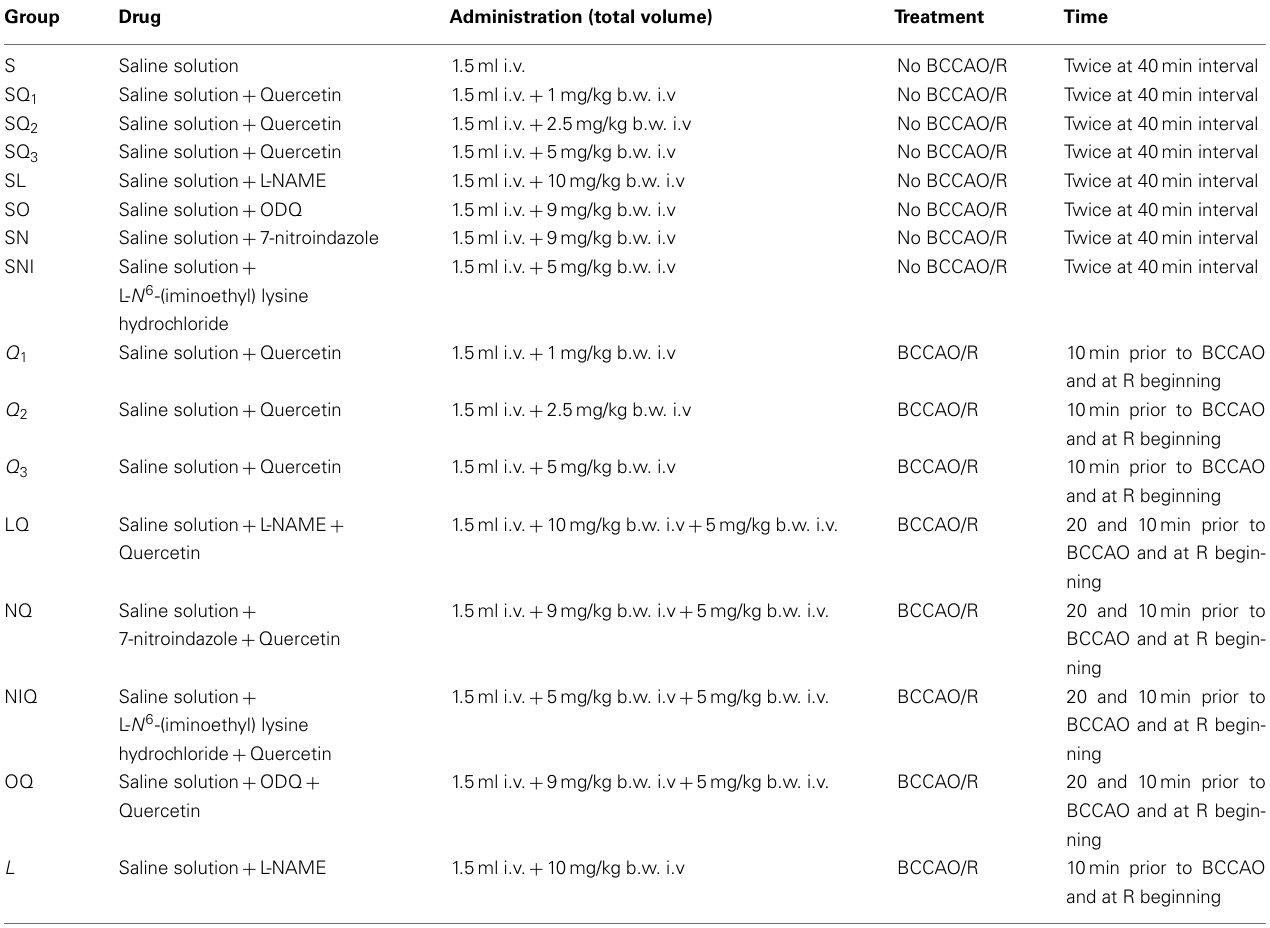
BCCAO/R, bilateral common carotid occlusion and